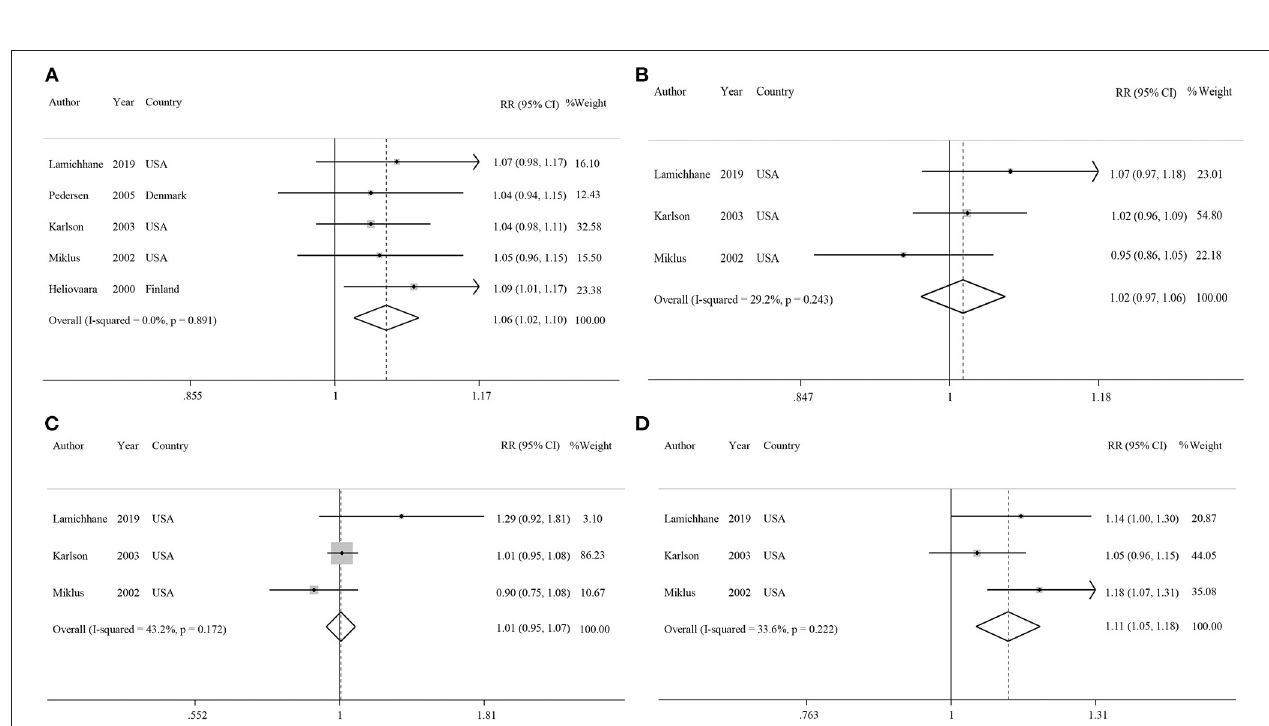
FIGURE 3 | Forest plots showing linear dose-response associations for each one cup/day increase of (A) coffee intake, (B) caffeinated coffee intake, (C) decaffeinated coffee intake, and (D) each 200 mg/d increase of caffeine intake with risk of rheumatoid arthritis.